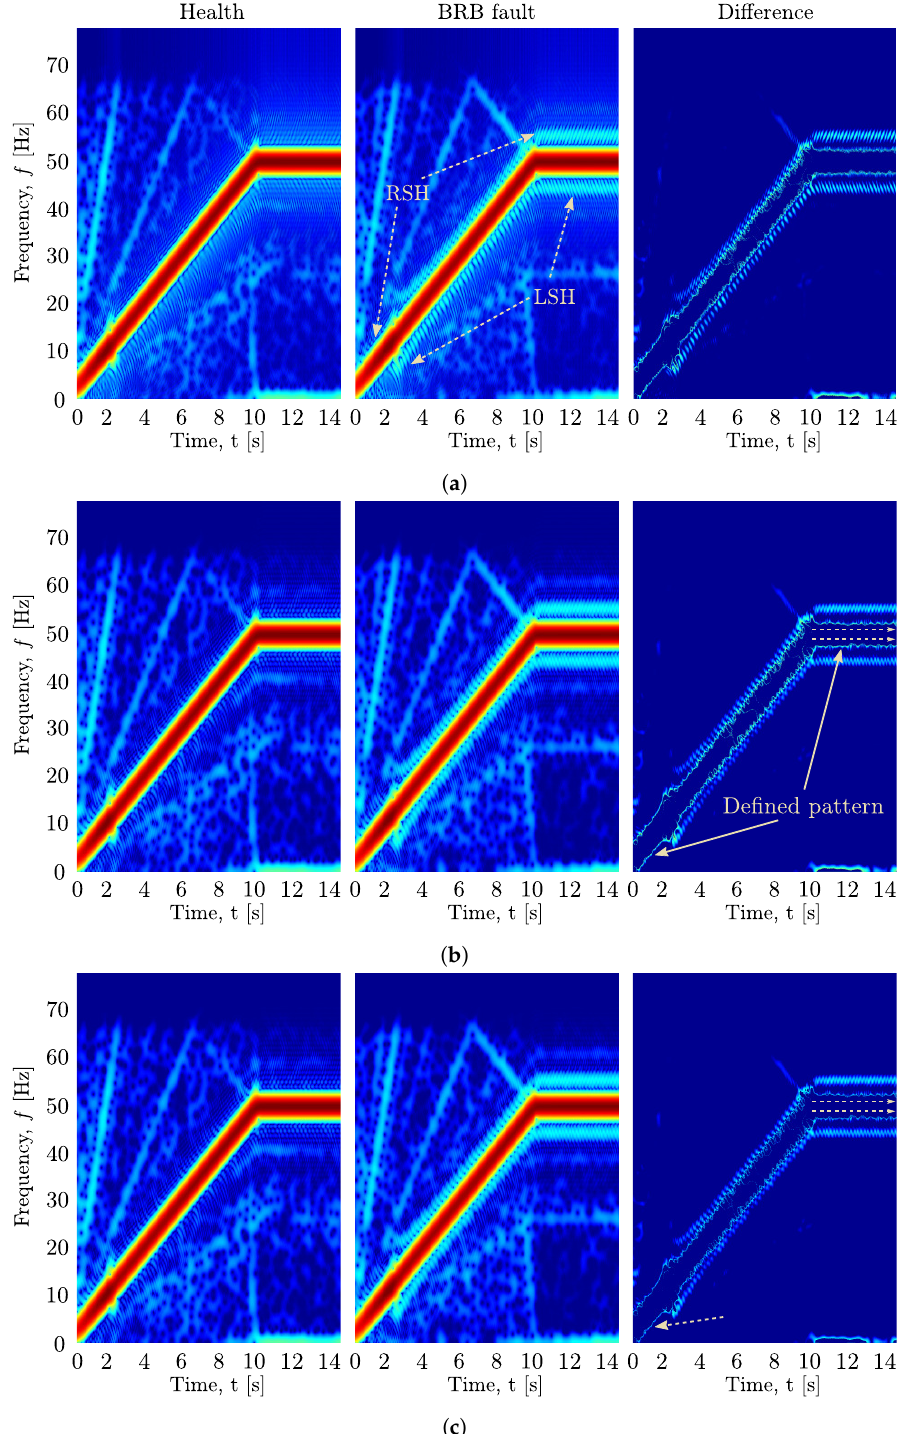
Figure 4. Time-frequency spectra of the experimental current signal with (Left) health and (Center) fault condition, and (Right) the difference of these spectra. Comparison of Windowed Fourier Transform (WFT) with fractional Gaussian windows-based on the ( a ) Caputo–Dzhrbashyan (CD); ( b ) Caputo–Fabrizio (CF); and ( c ) Atangana–Baleanu–Caputo (ABC)